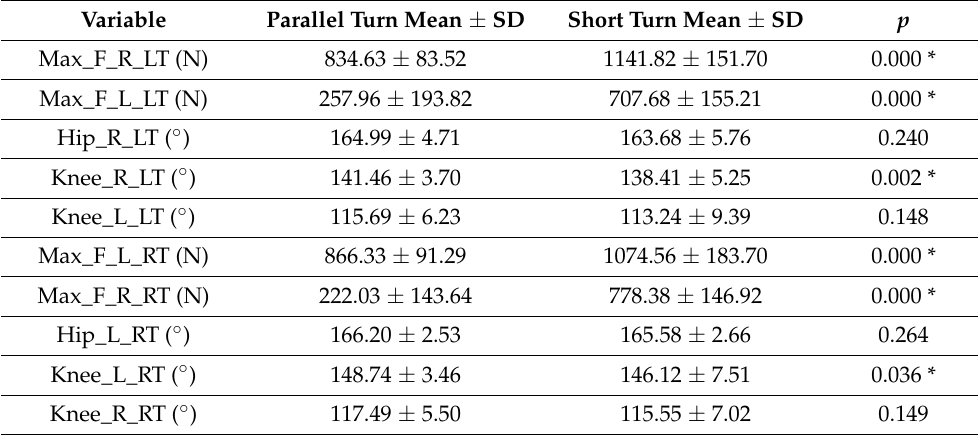
Table 1. Basic descriptive statistical parameters and t -test for variables PT and